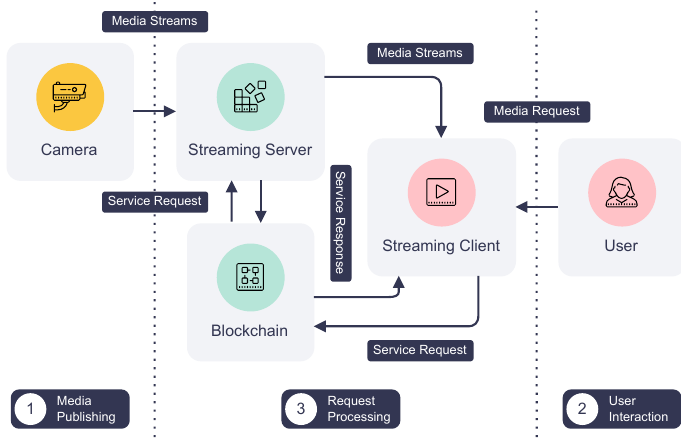
Figure 7. The architecture and data flow of Crystal